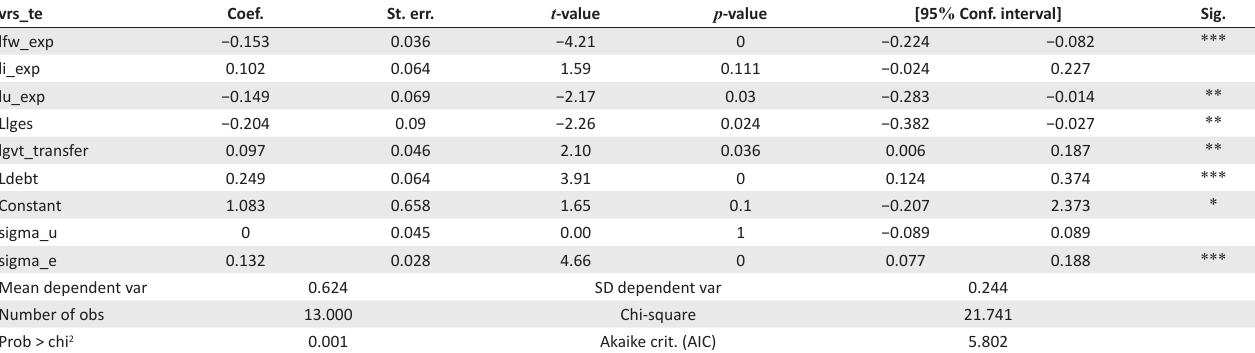
TABLE 2-A1: Random-effects tobit regression.